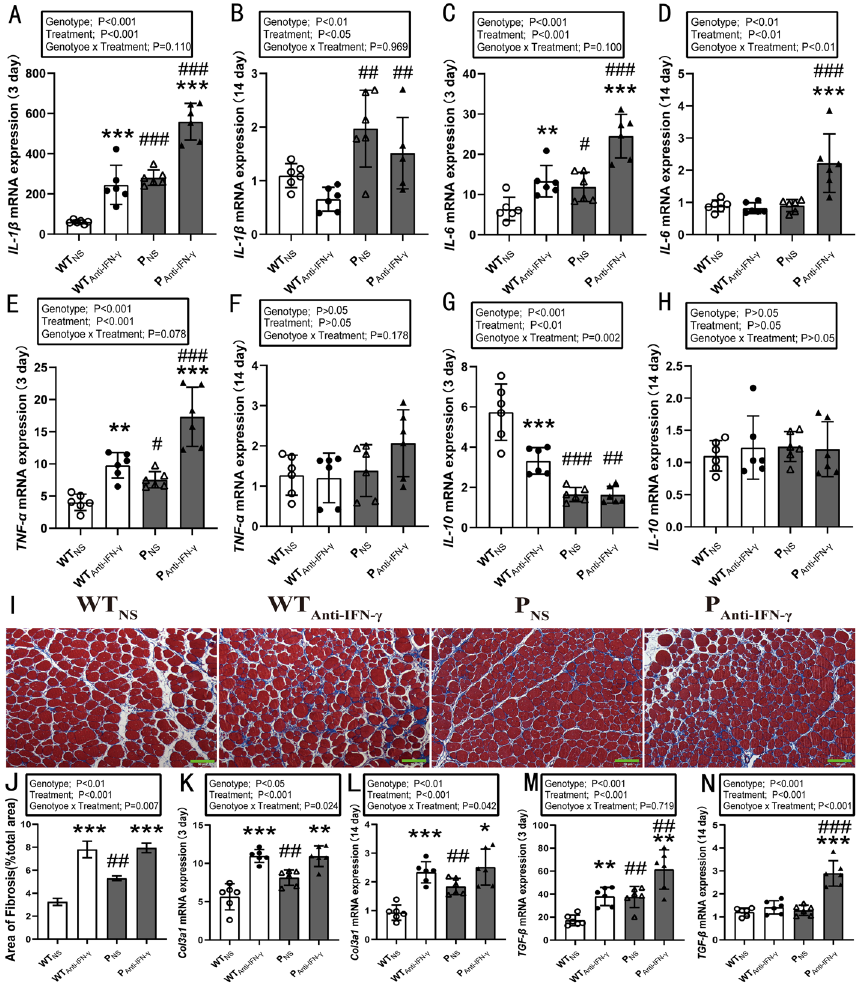
Fig. 2 PD-1 knockout and IFN-γ blockade exacerbate inflammation and fibrosis of injured skeletal muscle. WT NS : wild-type injured group with normal saline injection, WT Anti-IFN-γ : wild-type injured group with anti-IFN-γ antibody injection, P NS : PD-1 − / − injured group with normal saline injection, P Anti-IFN-γ : PD-1 − / − injured group with Anti-IFN-γ antibody injection. A IL-1β mRNA expression at 3 days post injury, B IL-1β mRNA expression at 14 days post injury, C IL-6 mRNA expression at 3 days post injury, D IL-6 mRNA expression at 14 days post injury, E TNF-α mRNA expression at 3 days post injury, F TNF-α mRNA expression at 14 days post injury, G IL-10 mRNA expression at 3 days post injury; H IL-10 mRNA expression at 14 days post injury, I Masson’s trichrome staining of injured TA muscle of mice of both genotypes injected with CTX, along with either anti-IFN-γ antibody or normal saline at 14 days post injury, J Quantification of area of fibrosis as in I , K Col3a1 mRNA expression at 3 days post injury, L Col3a1 mRNA expression at 14 days post injury, M TGF-β mRNA expression at 3 days post injury, N TGF-β mRNA expression at 14 days post injury. * P < 0.05, ** P < 0.01, *** P < 0.001, different from NS treatment when comparing the same genotype. # P < 0.05, ## P < 0.01, ### P < 0.001, different from WT mice when comparing the same treatment. Data are shown as mean standard deviation (SD), n 6 ( A – H , K – N ), n 3 ( J ). Green scale bar, 50 ± = =